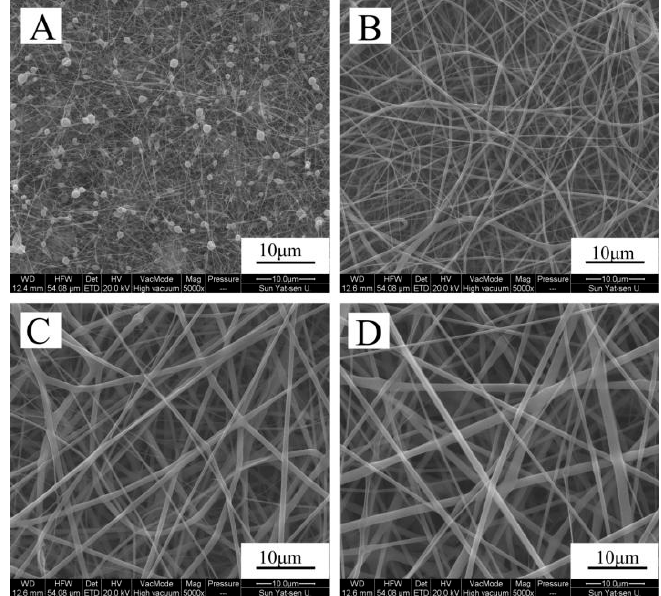
Figure 1. Scanning electron microscope (SEM) images of the surface morphology of zein ( A ); zein/gelatin-1 ( B ); zein/gelatin-2 ( C ); and zein/gelatin-3 ( D ) electrospun nanofibers.